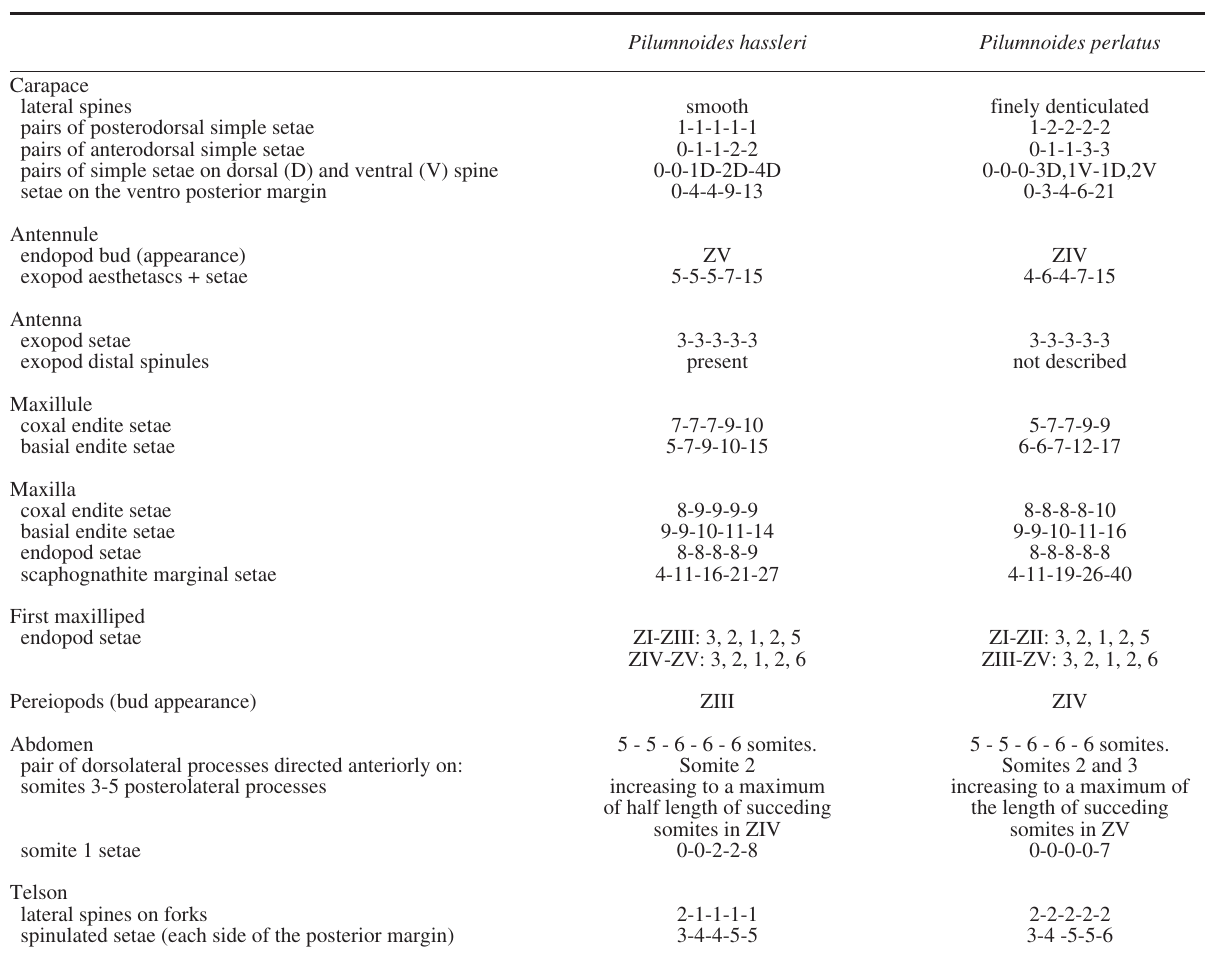
Table 3. – difference between the zoeal morphology (all stages) of Pilumnoides hassleri and P. perlatus (described by Fagetti and Campo- donico,